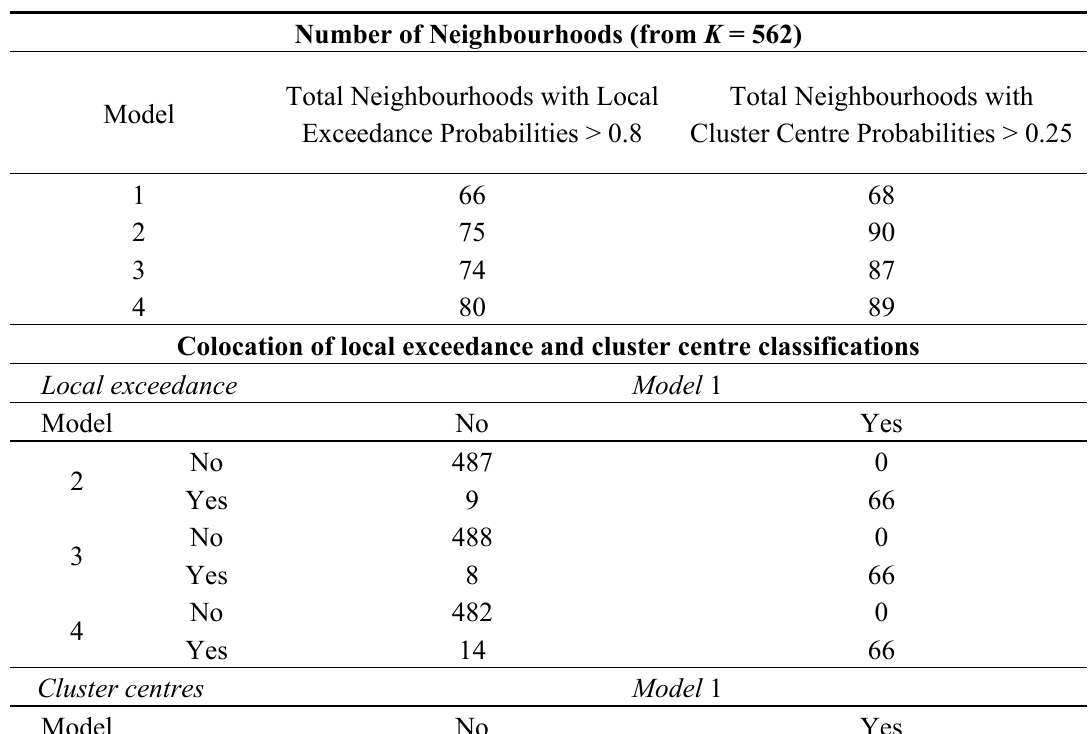
Table 3. Classification of asthma risk in